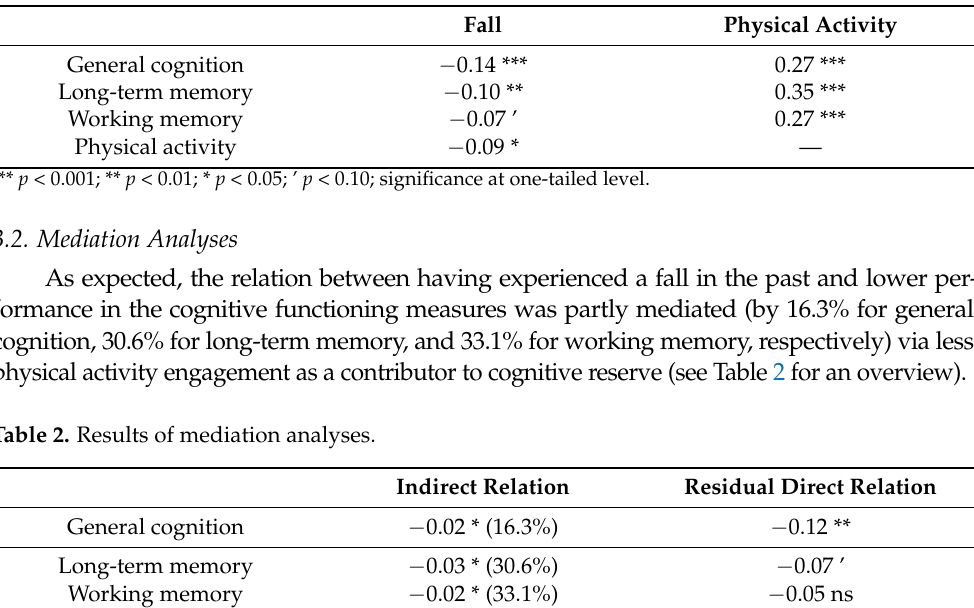
Table 1. Relationships between analyzed variables.